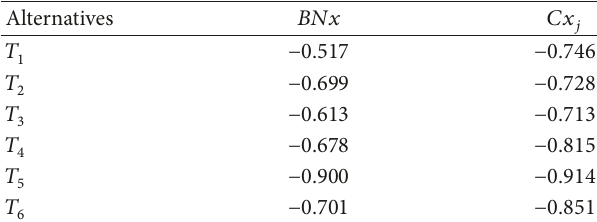
Table 14: 𝐵𝑁𝑥 and 𝐶𝑥 𝑗